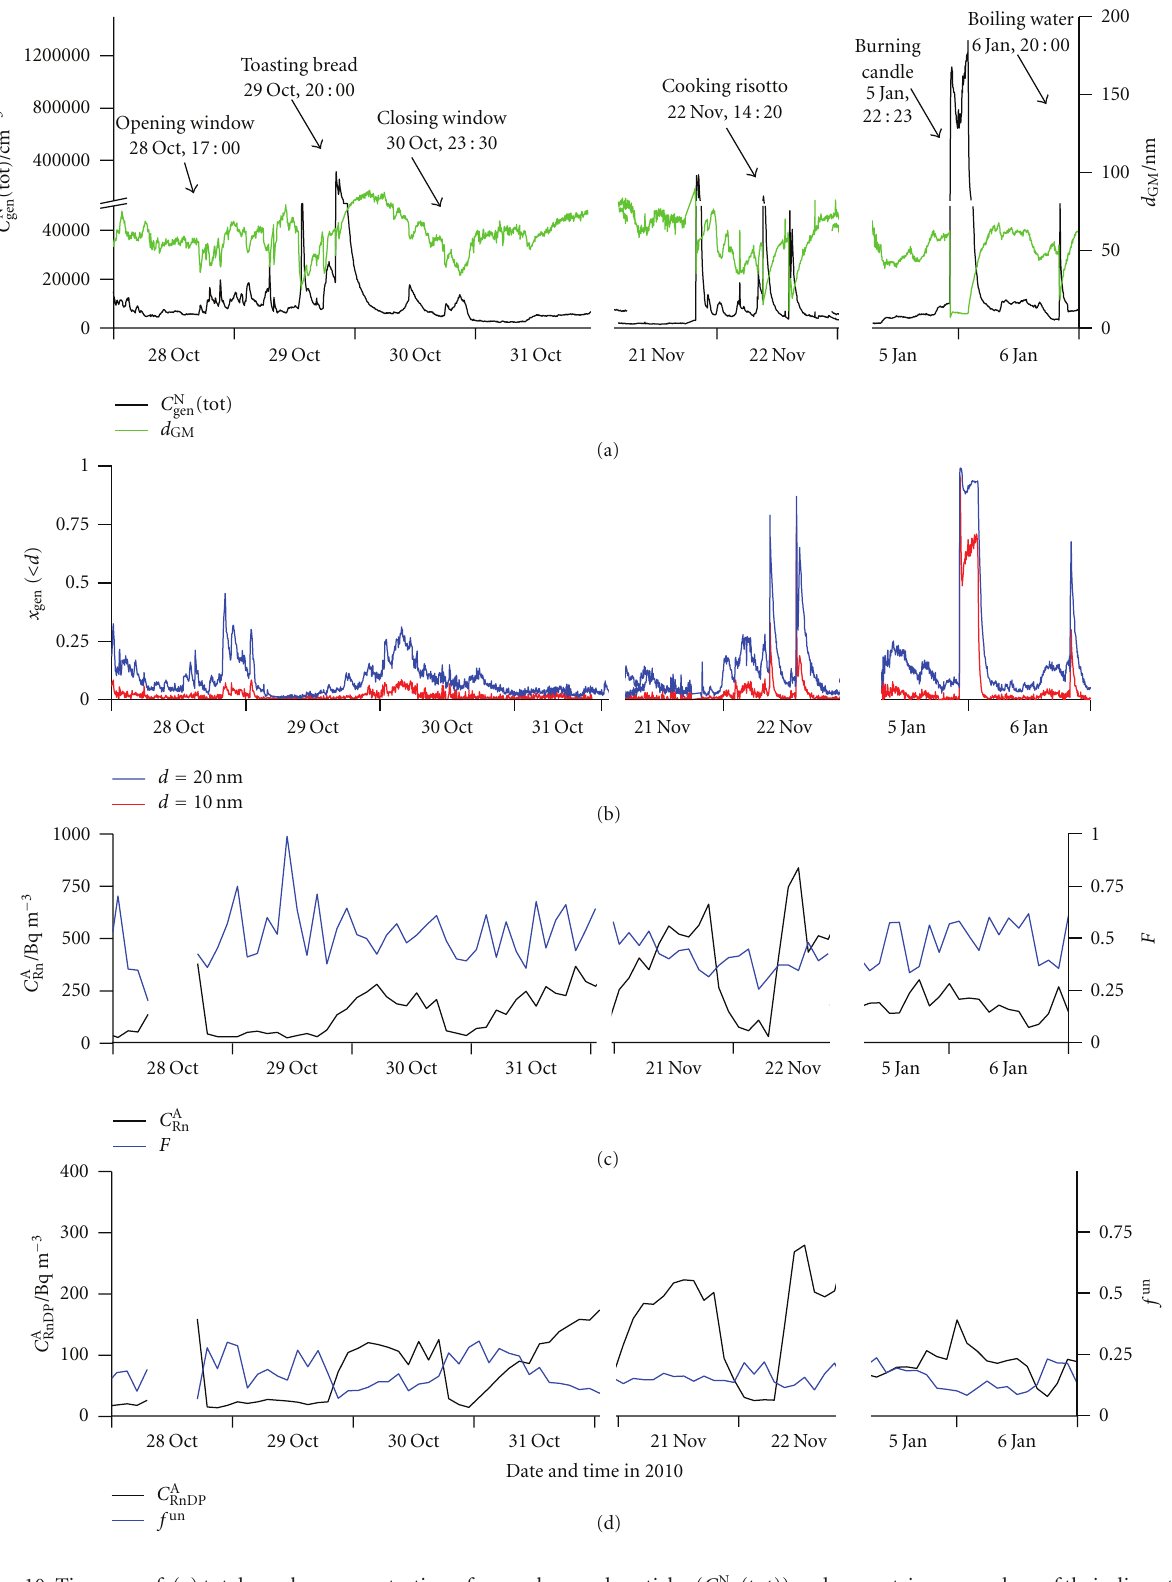
Figure 10: Time run of: (a) total number concentration of general aerosol particles ( C N ( d GM ), (b) number fraction of particles smaller than 10nm ( x gen ( < 10)) and smaller than 20nm ( x gen ( < 20)), (c) activity concentration ) and equilibrium factor between Rn and RnDP ( F ), and (d) equilibrium equivalent activity concentration of radon decay of radon ( C A Rn ) and activity fraction of the unattached RnDP ( f un ), in indoor air from October 28 to January products ( C A RnDP